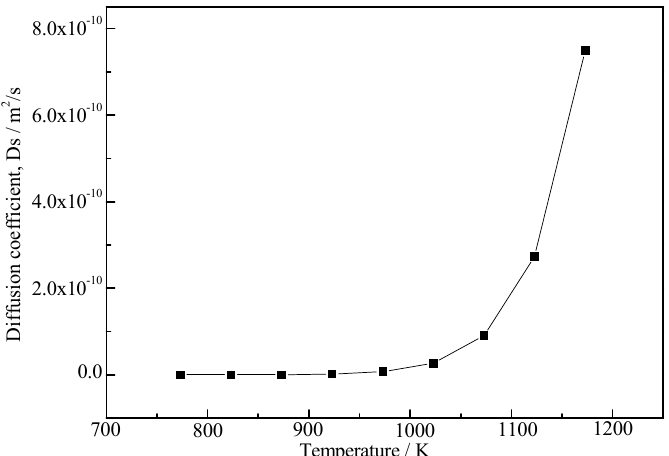
Figure 12. The relationship between the diffusion coefficient and temperature.